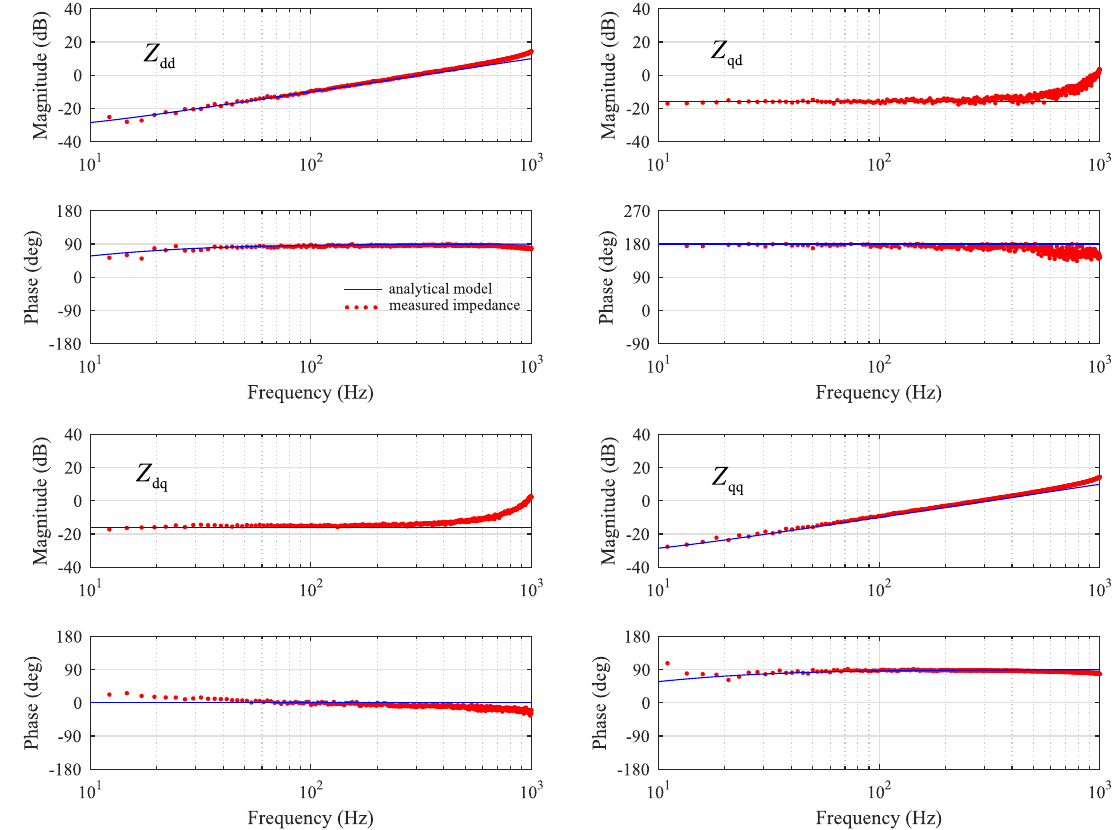
Figure 6. Measured and modeled grid impedance in dq-domain when amplifier group number 1 is configured to operate in current control mode and used to inject the excitation signal.